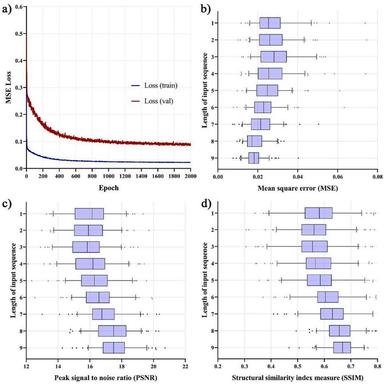
Model performance for predicting the 11th frame based on different lengths of input sequence. (a) the changing trend of training and validation loss; (b)-(d) box-whisker plots of MSE, PSNR, and SSIM.